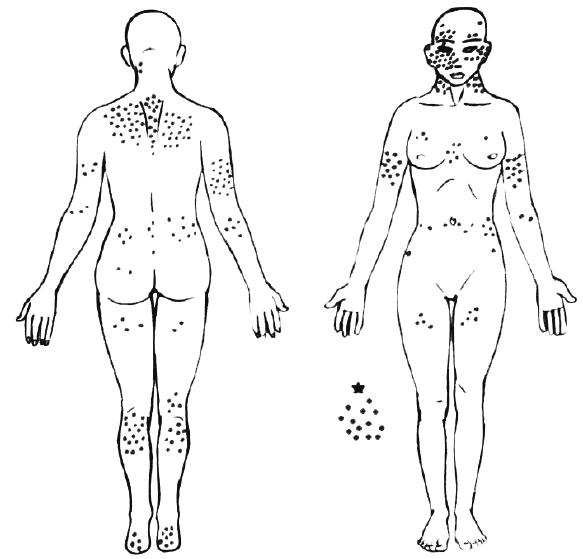
Figure 4: Anatomical sites of cutaneous melanoma lesions in women patients in western region of Santa Catarina, Brazil, from 2002 to 2009 ( n = 292). ∗ Patients with metastatic CM for lymph nodes and unknown primary cutaneous site on first